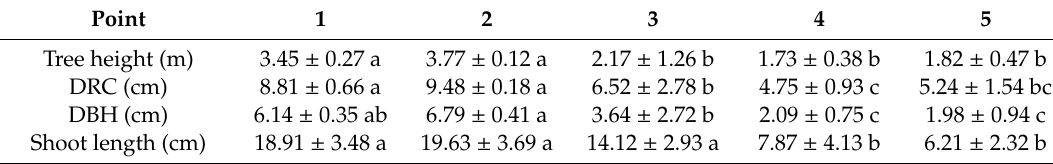
Table 1. Growth responses of Mongolian pines planted for nine growing seasons according to changes in sand dune height. Tree height: Values with di ff erent small letters indicate significant di ff erences (Jonckheere–Terpstra test, p ≤ 0.05). Diameter at root collar (DRC), diameter at breast height (DBH): Values with di ff erent small letters denote significant di ff erences (Dunnett’s T3 test, p ≤ 0.05). Shoot length: Values with di ff erent small letters represent significant di ff erences (Duncan’s multiple range test, p ≤